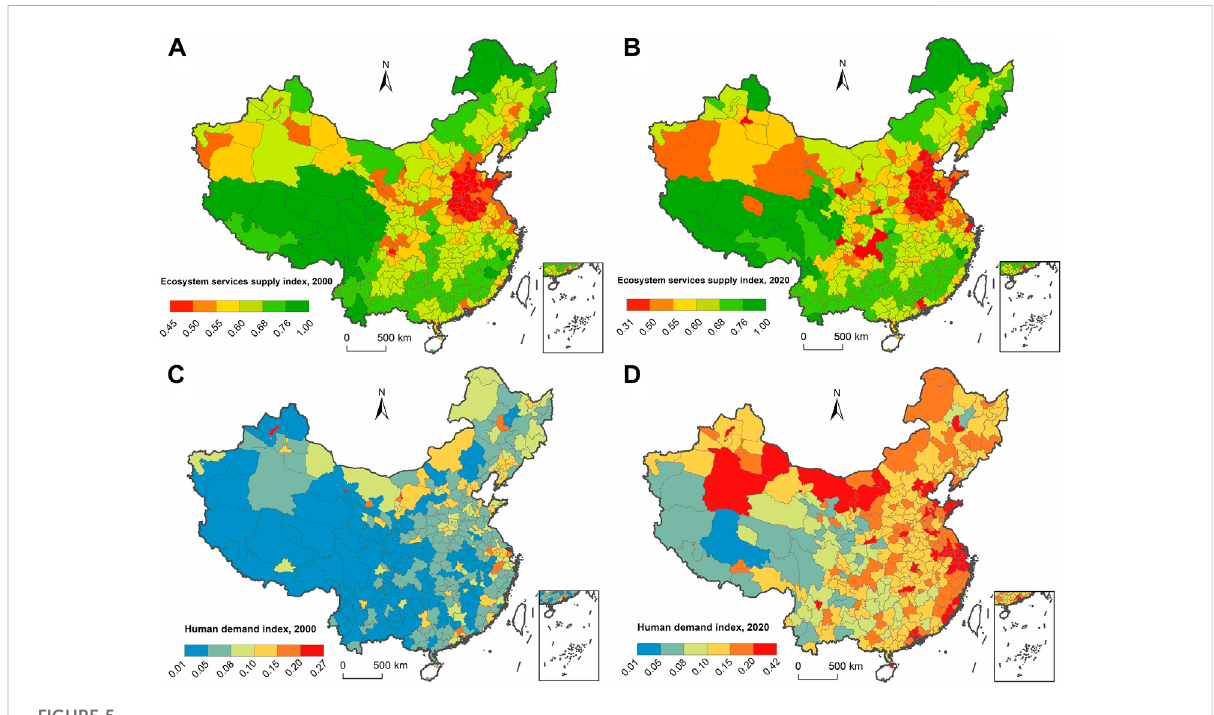
FIGURE 5 Spatial evolution of the ESSI and HMDI in China from 2000 to